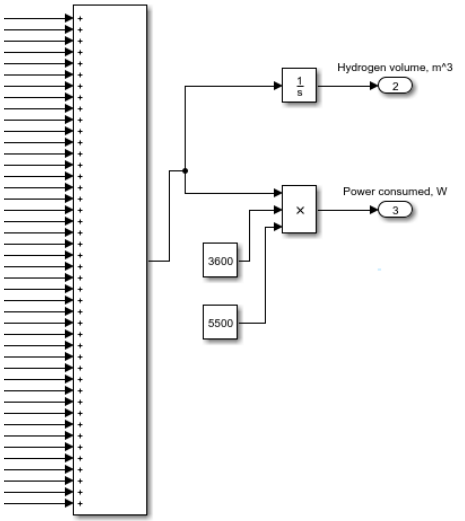
Figure 9. The subsystem of the electrolyzer cell stack (place ‘A’).